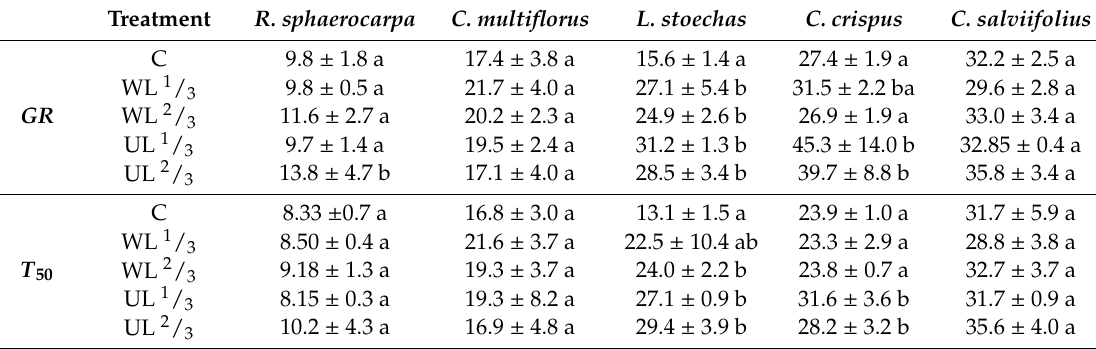
Table 2. E ff ect of leaf litter on the germination rate ( GR ) and time to 50% of germination ( T 50 ) of the analysed species. N = 4.